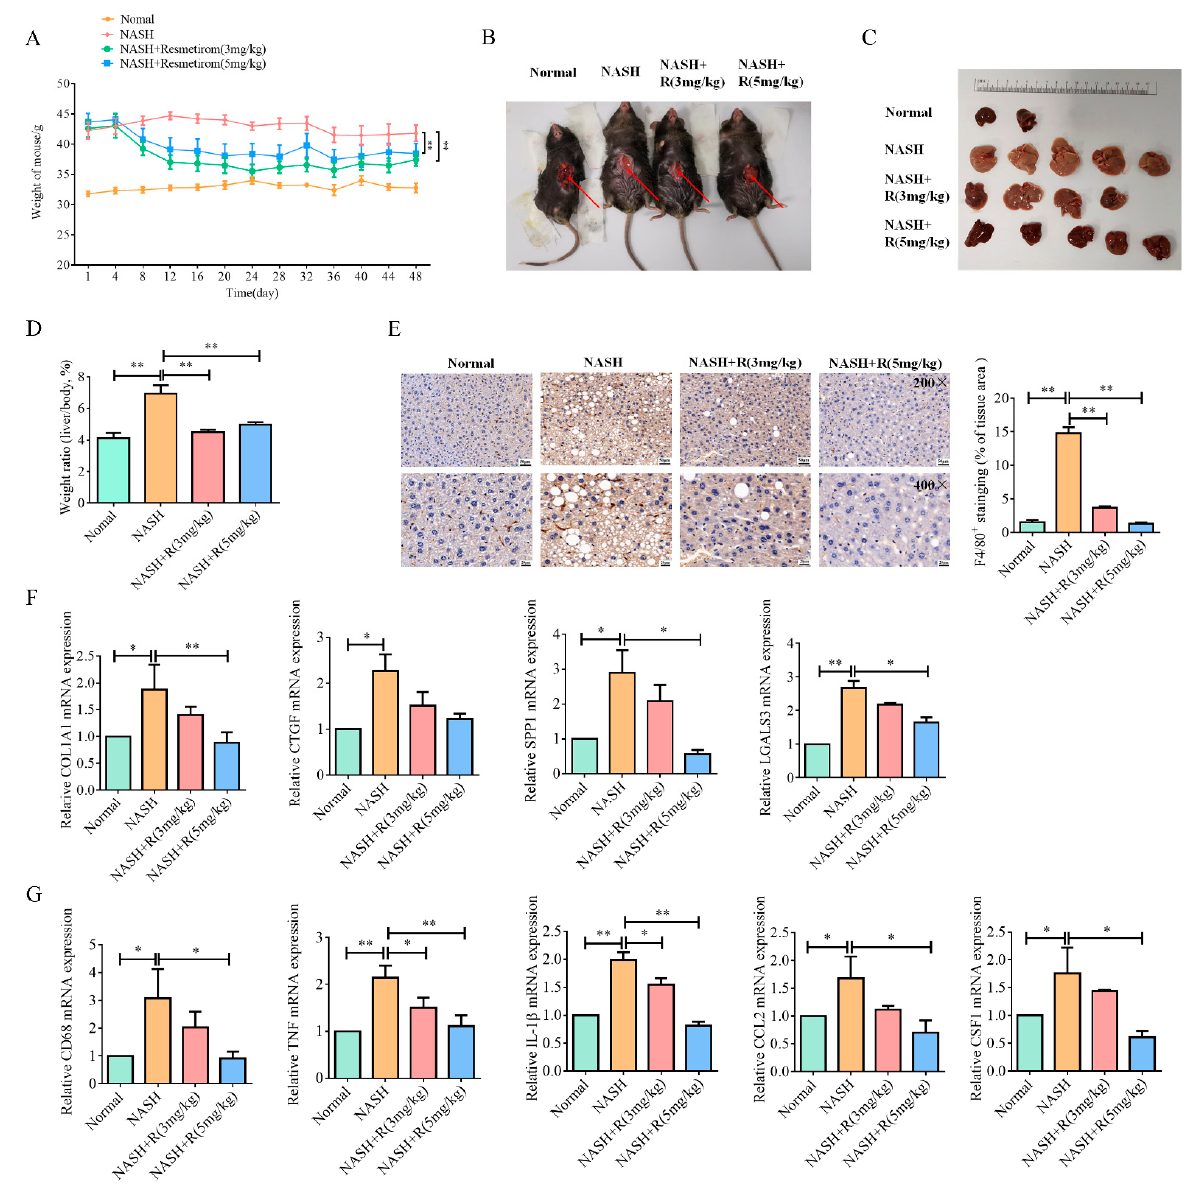
Figure 5. Resmetirom significantly suppressed NASH in mouse model generated by AMLN diet.